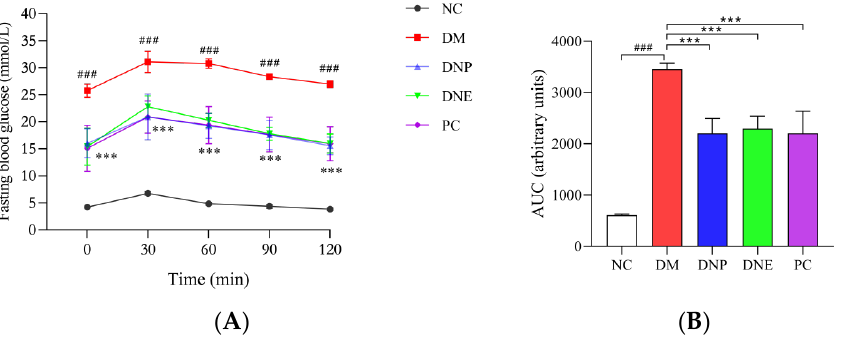
Figure 11. Effect of D. nobile on oral glucose tolerance of T2DM rats: blood glucose levels ( A ) and their AUCs ( B ). All data are expressed as mean ± S.D. (n = 6 per group). Compared with the NC group, ### p < 0.001; compared with the DM group, *** p < 0.001.